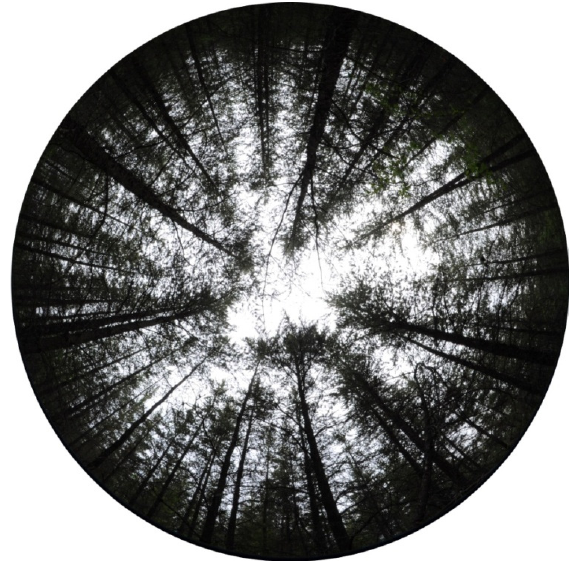
Figure 6. DHP image example (Jack Pine LAI = 1.5).